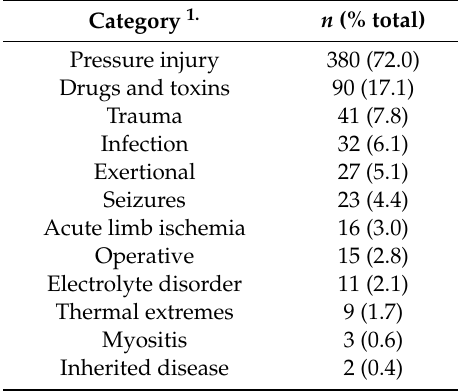
Table A1. Implicated causes of rhabdomyolysis.